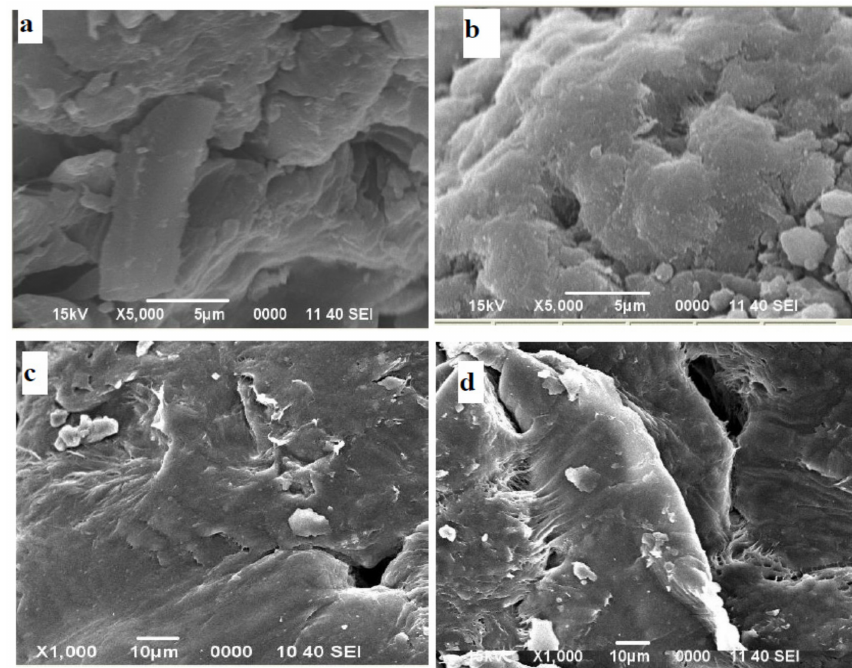
Figure 3. Images of ( a ) PANI ( b ) PEO ( c ) PANI-PEO-KNO 3 and ( d ) PANI-PEO-NaNO 3